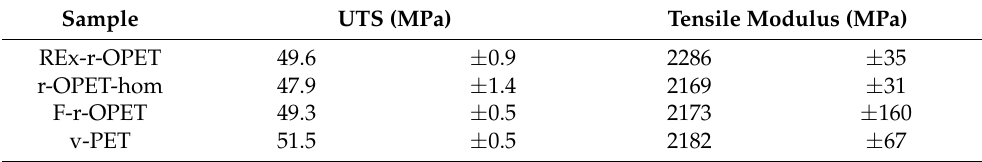
Table 1. Tensile properties (DIC) of the